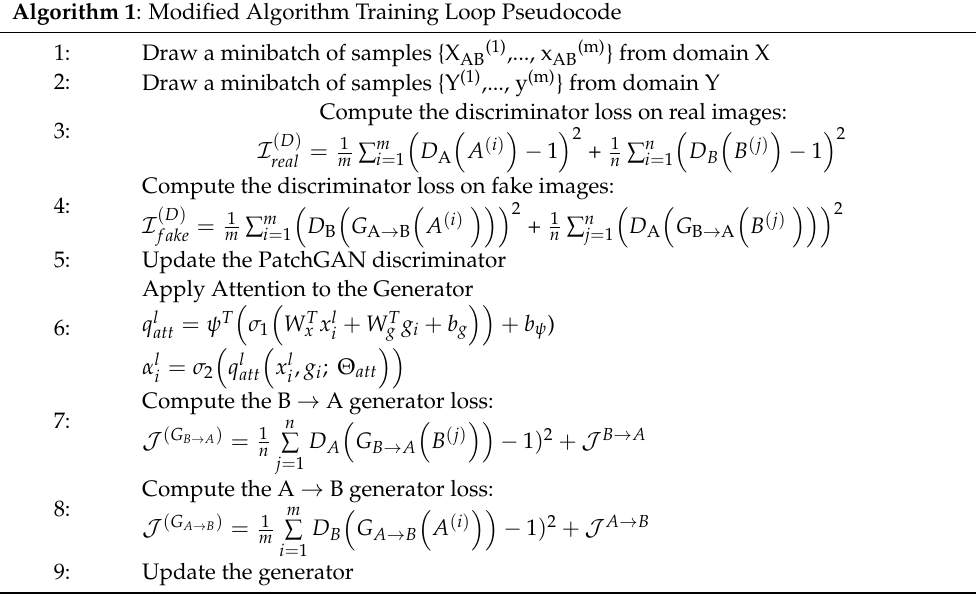
Algorithm 1 : Modified Algorithm Training Loop